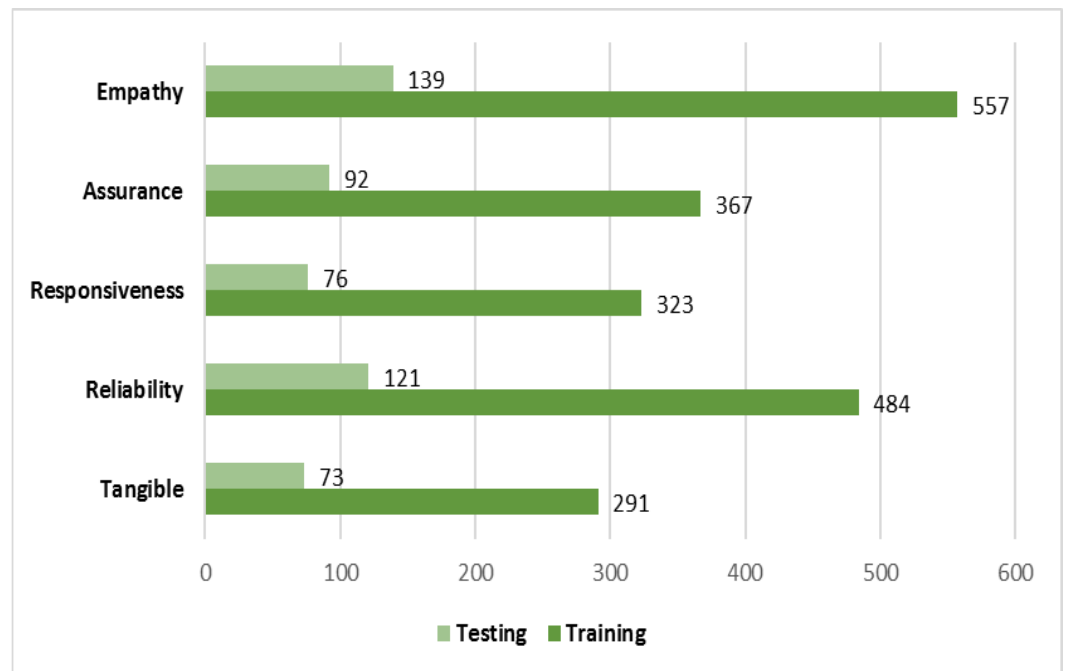
Figure 2. The number of records in training and test datasets for each SERQUAL domain. Table 1. Performance of ML models based on 5-fold cross